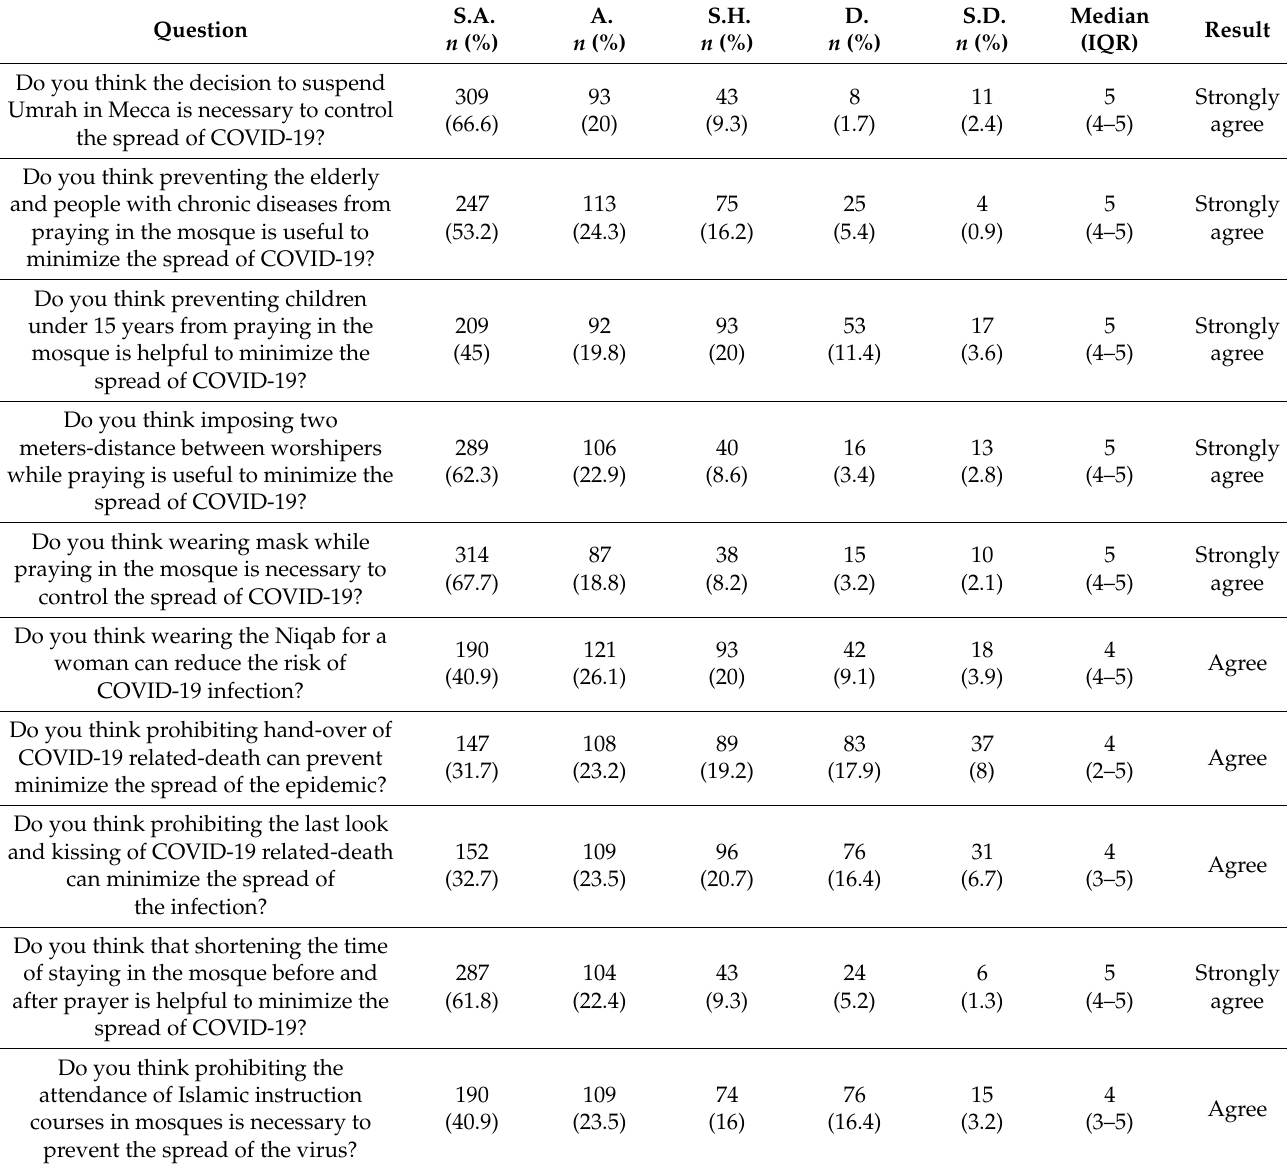
Table 2. The proportion of different Islamic attitudes toward COVID-19 among study population in